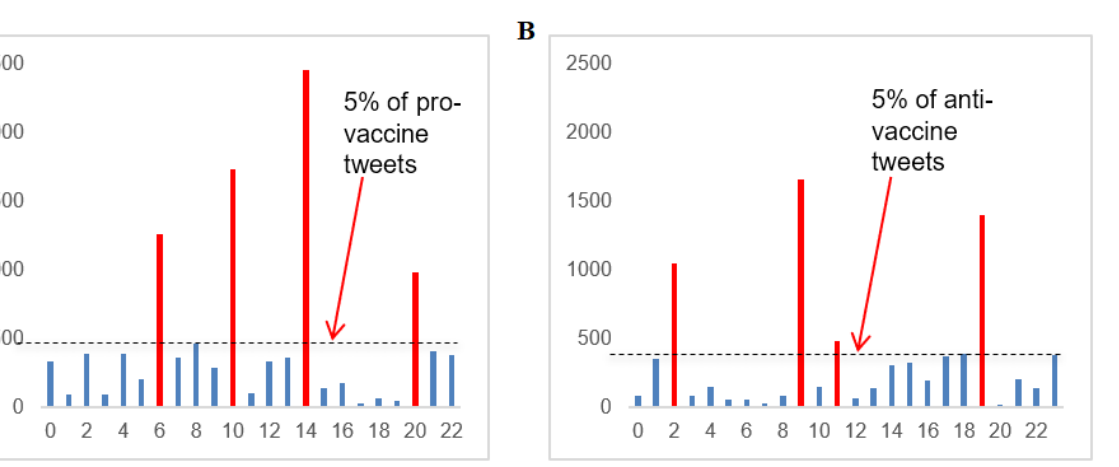
Figure 2. Provaccine (A) and antivaccine (B) cluster counts. In A, clusters 6, 10, 14, and 20 each hold over 5% of the tweets in the data set. In B, clusters 2, 9, 11, and 19 each hold over 5% of the tweets in the data